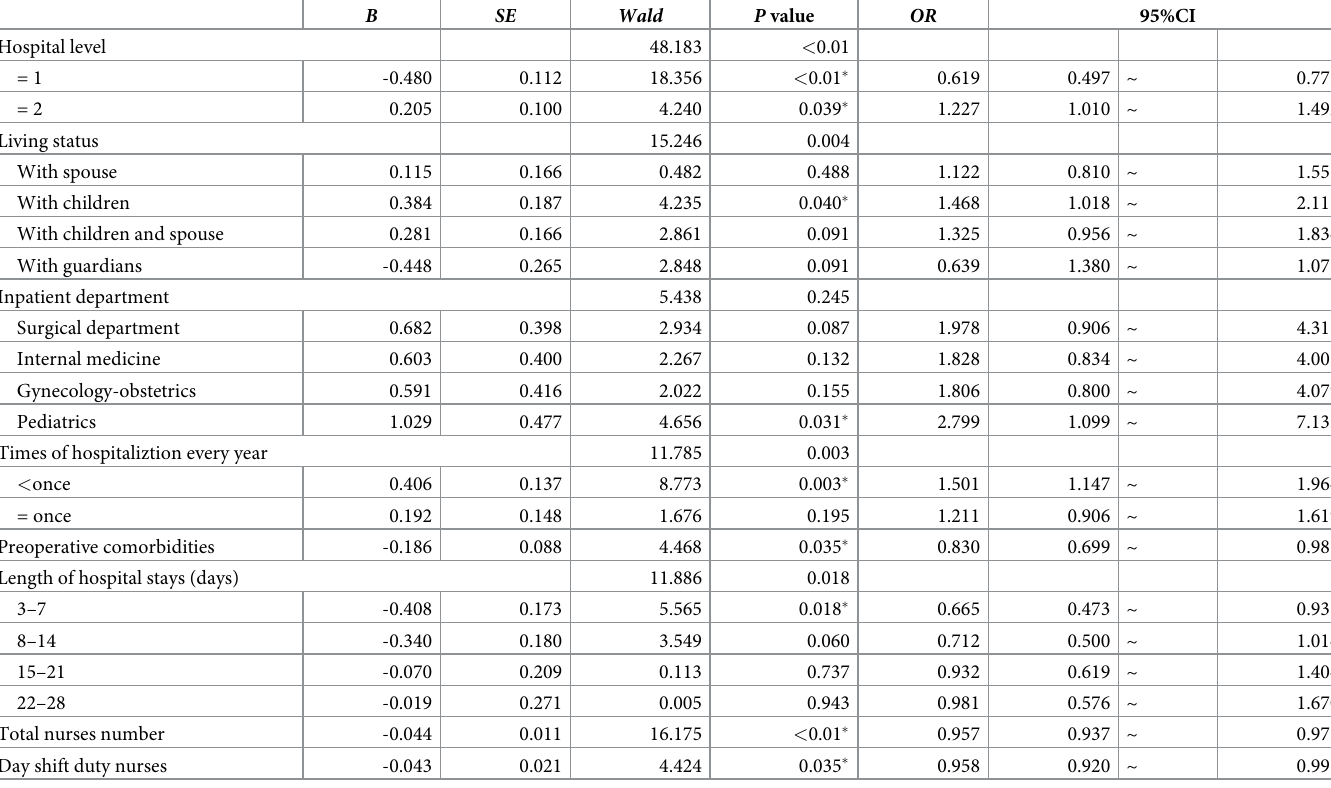
Table 3. Risk factors for patients’ favorite nurse with good